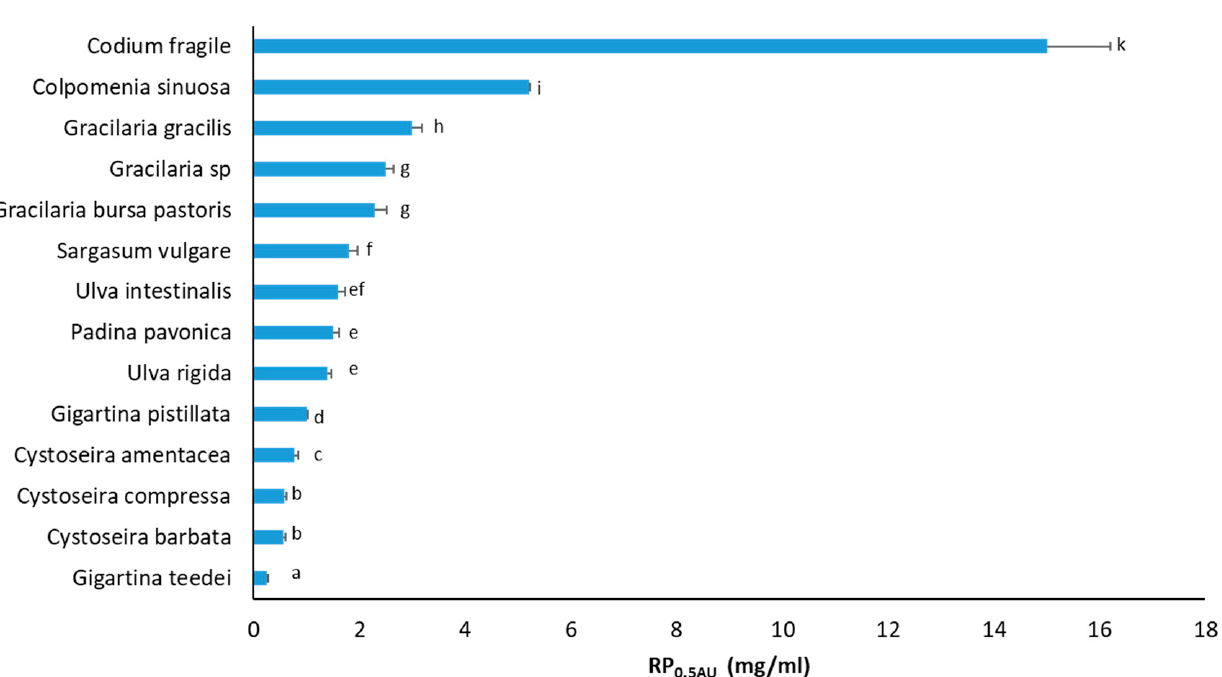
Figure 2. RP activity of macroalgae extracts. The RP 0.5AU values are presented as the mean ± SD from at least three independent experiments. All RP 0.5AU values are statistically significantly ( p < 0.05) different compared to controls. Values having different letters are statistically different between them ( p < 0.05).